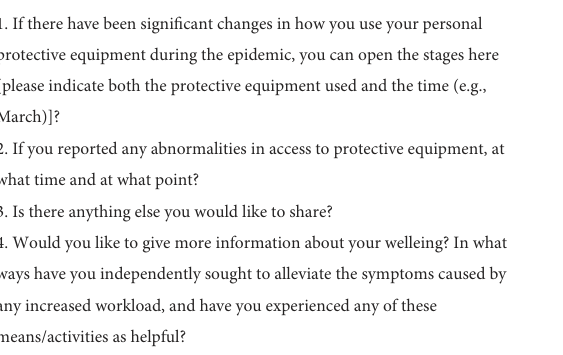
TABLE 1 Free-text questions included in the